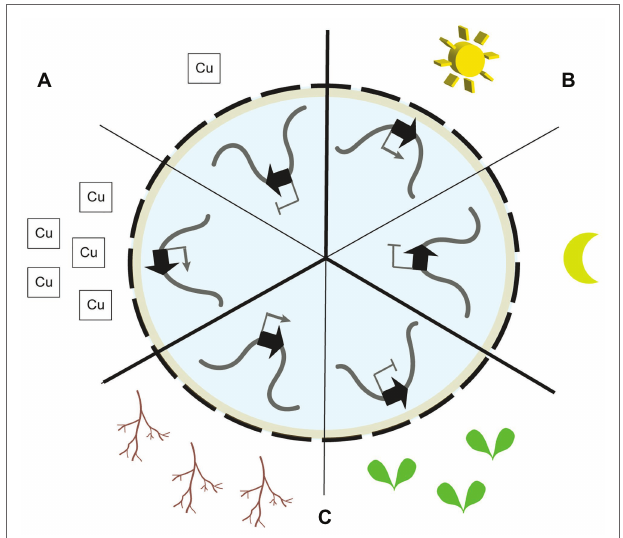
FIGURE 1 | Nuclear gene re-positioning in response to environmental and developmental signals. (A) The copper-associated ( CA ) gene cluster is located at the nuclear envelope (NE) upon plant exposure to copper. Peripheral localisation is accompanied by transcriptional activation. In the absence of copper, the cluster is located away from the NE and silenced (Sakamoto et al., 2020). (B) The light-induced CAB gene cluster is located at the NE upon plant exposure to light. In absence of light, the cluster is located away from the NE and silenced (Feng et al., 2014). (C) The silenced thalianol biosynthetic gene cluster is located at the nuclear periphery (NP) in leaf cells. In roots, when transcriptionally active, the cluster is positioned away from the nuclear periphery (Nützmann et al.,